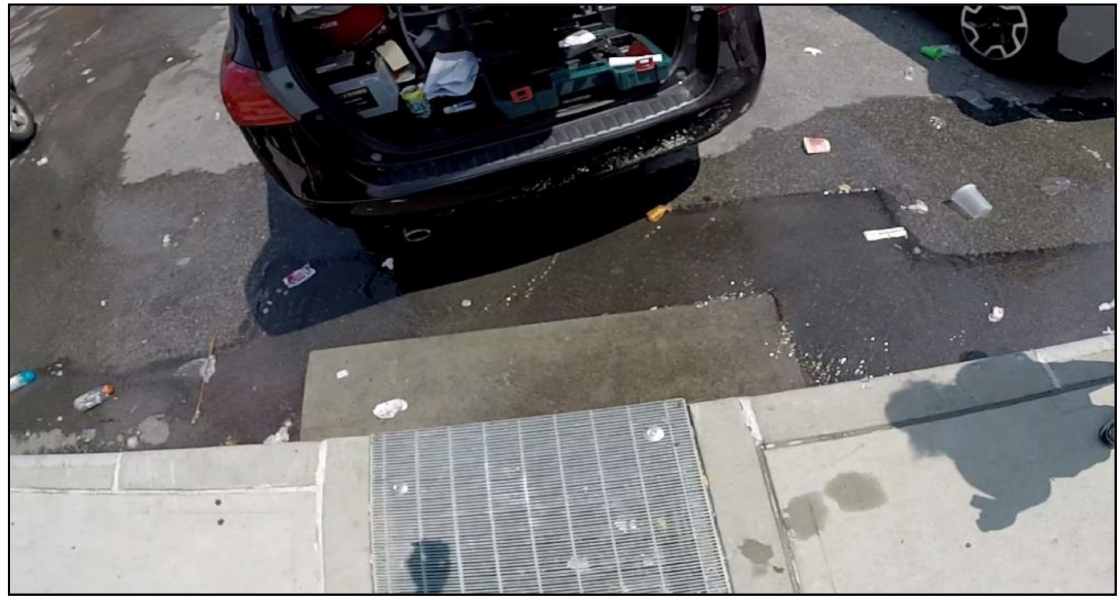
Figure 8. Photograph of SE inlet showing bypass at